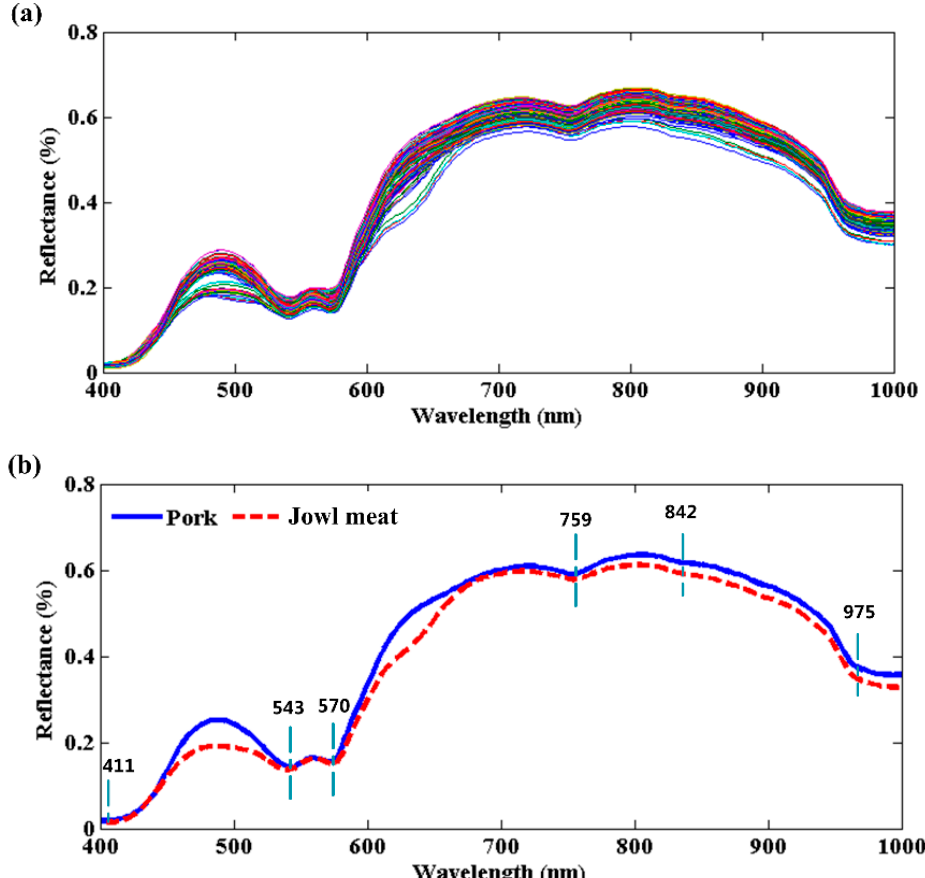
Figure 1. Spectral characteristics of prepared samples in the visible and near-infrared region. ( a ) Adulterated samples, ( b ) Mean raw spectra of pure pork and jowl meat.